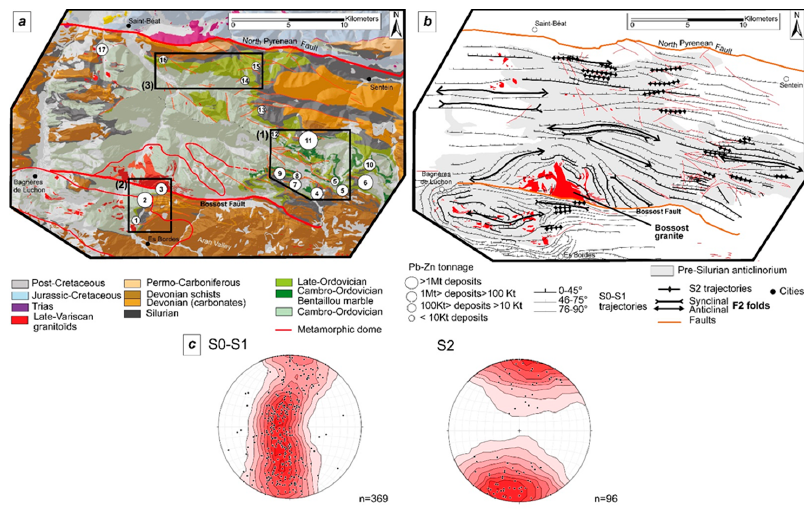
Figure 2. The Bossòst Anticlinorium. ( a ) Geological map with positions of the three districts: (1) Bentaillou-Liat-Urets district, see Figures 3 and 4; (2) Margalida-Victoria-Solitaria district, see Figure 5; and (3) Pale Bidau-Argut-Pale de Rase district, see Figure 6. Pb-Zn deposits are numbered as